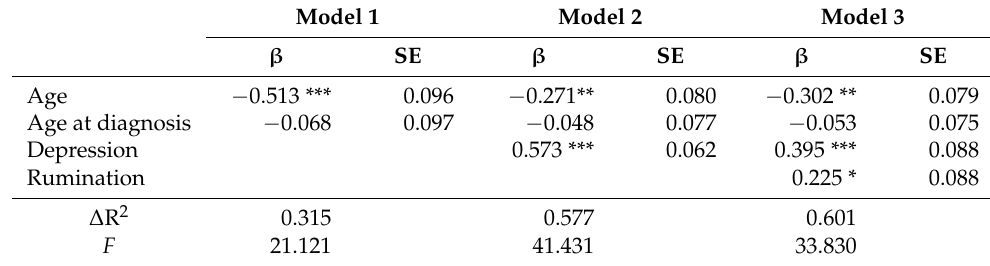
Table 3. Analysis of predictors of suicidal ideation in patients with depression ( N = 95). Model